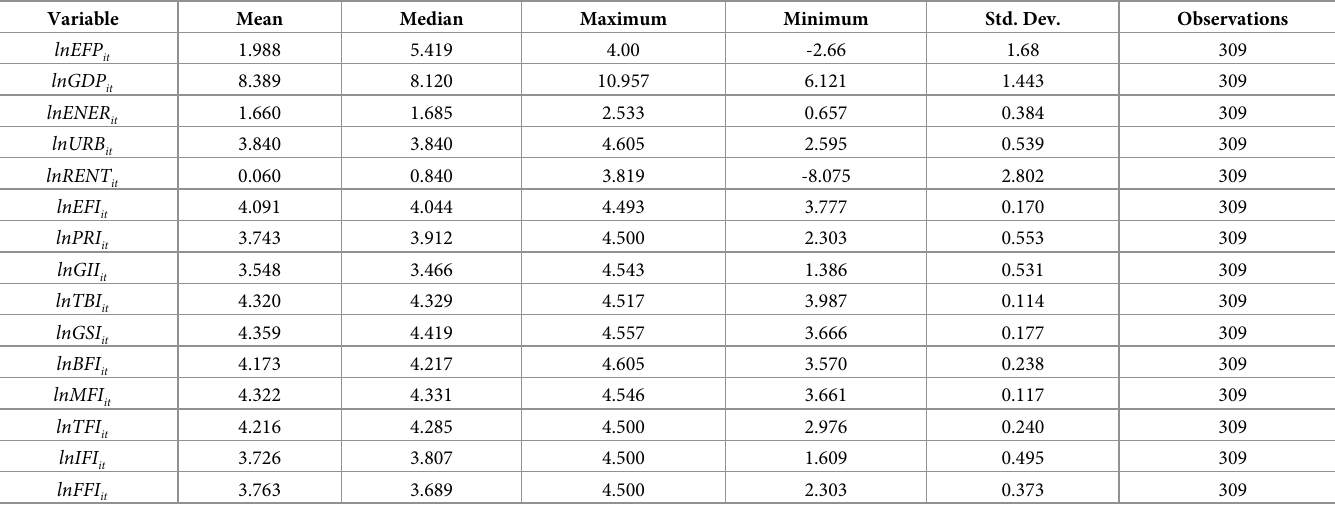
Table 2. Summary statistics over the years